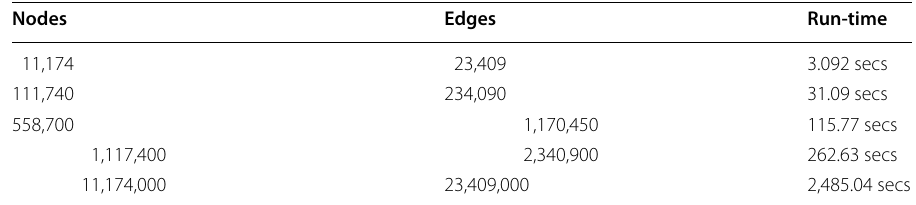
Table 5 Run-time by number of nodes Nodes Edges